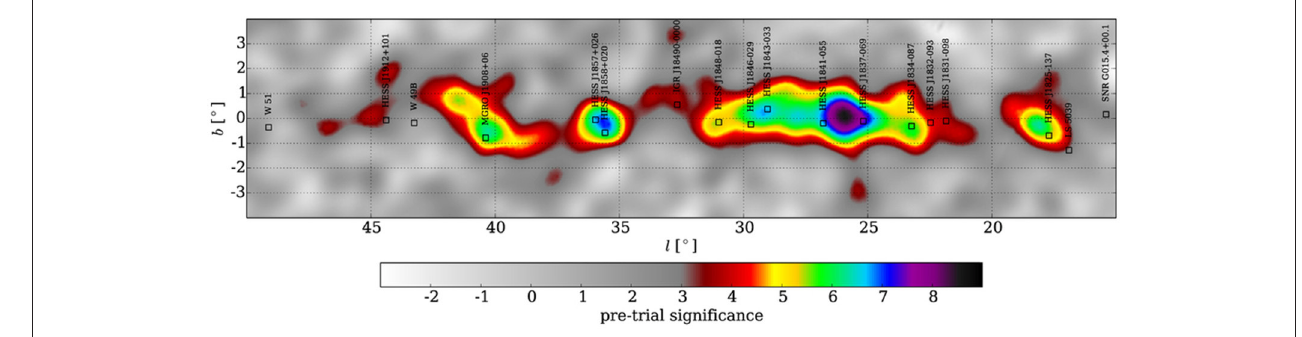
FIGURE 2 | Significance map.